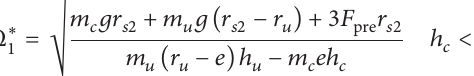
𝐹 pre denotes the 𝐽 𝑟 = 𝑟 /2 1 3 is 𝑠2 𝑠1